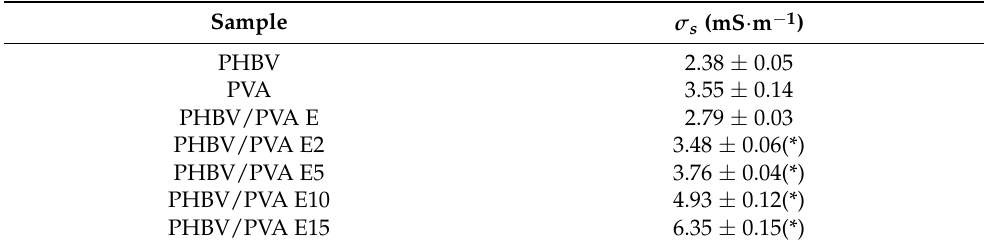
Table 5. Surface electrical conductivity of neat PHVA, PVA, PHBV/PVA 30/70 network and compos- ites with from 2 up to 15% of PPy